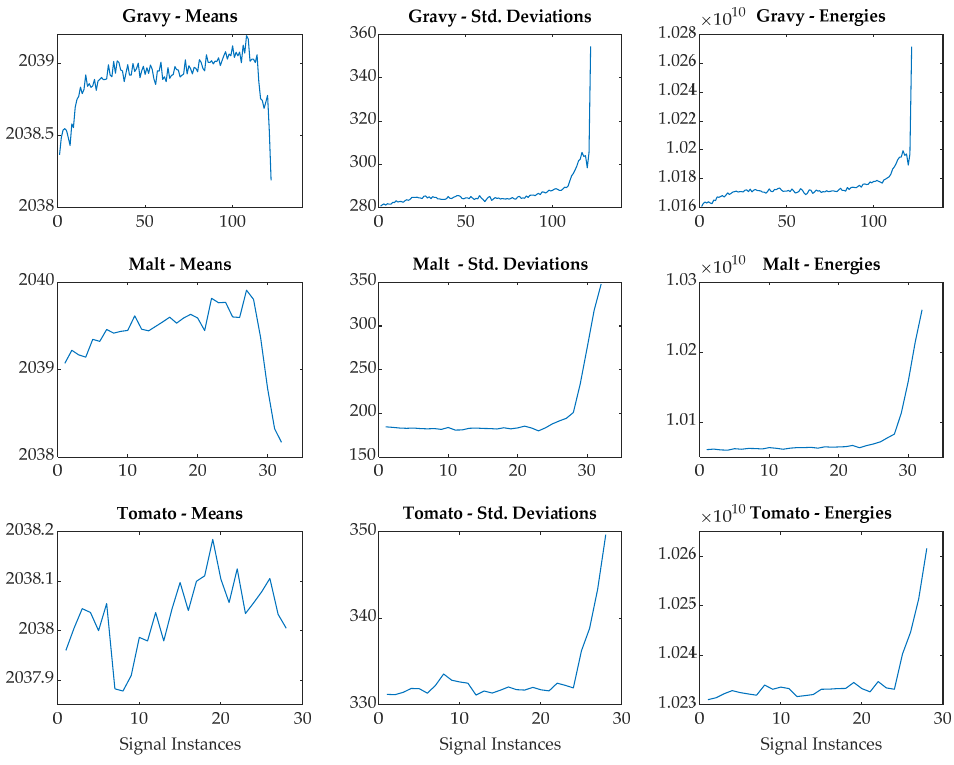
Figure 6. Signal features examples for the gravy, malt, and tomato.